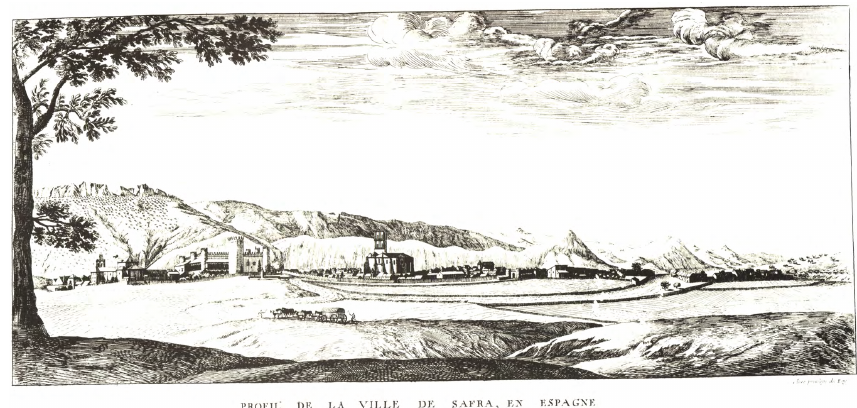
Figure 1. The town of Zafra in about 1660. The two important buildings on the left-hand side of the image are the Santa Clara Convent (first on the left) and the Alcázar de Zafra (second on the left). The important building in the central part of the image is the Collegiata church. The “Peñas del Castellar” mentioned by Fr. Joseph de Santa Cruz are the highest hills seen on the left of the image (courtesy of the Zafra Municipal Historical Archive).